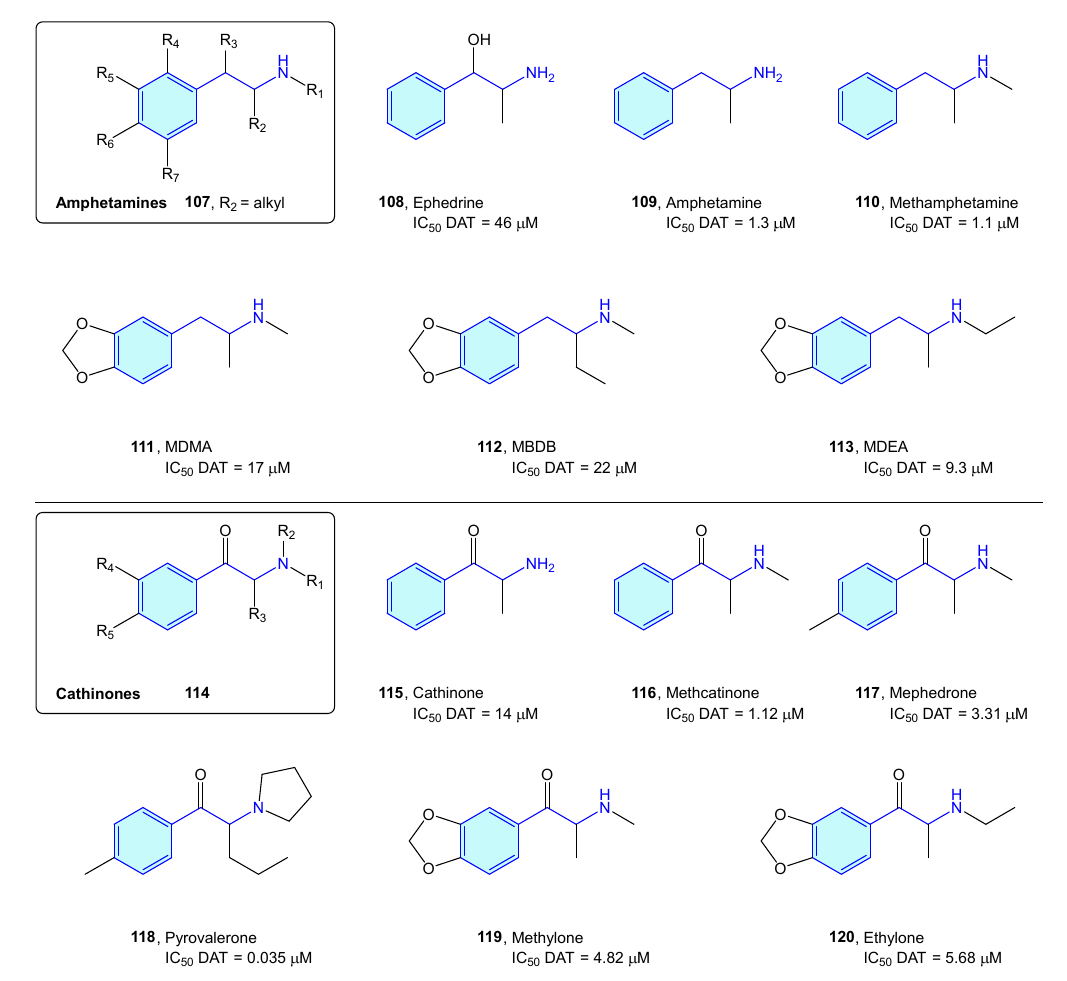
Figure 13 . Amphetamine/cathinone-type families.